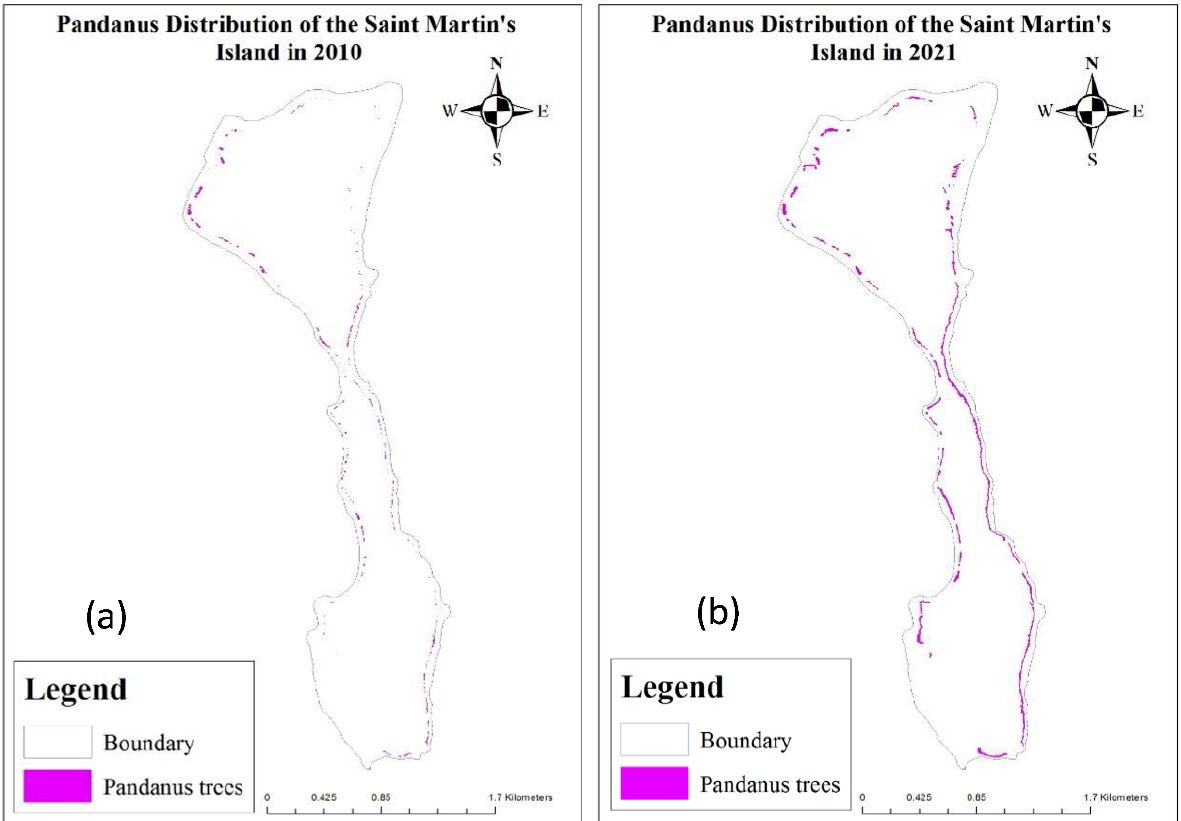
Figure 6. ( a ) Pandanus tree distribution map of 2010. ( b ) Pandanus tree distribution map of 2021.